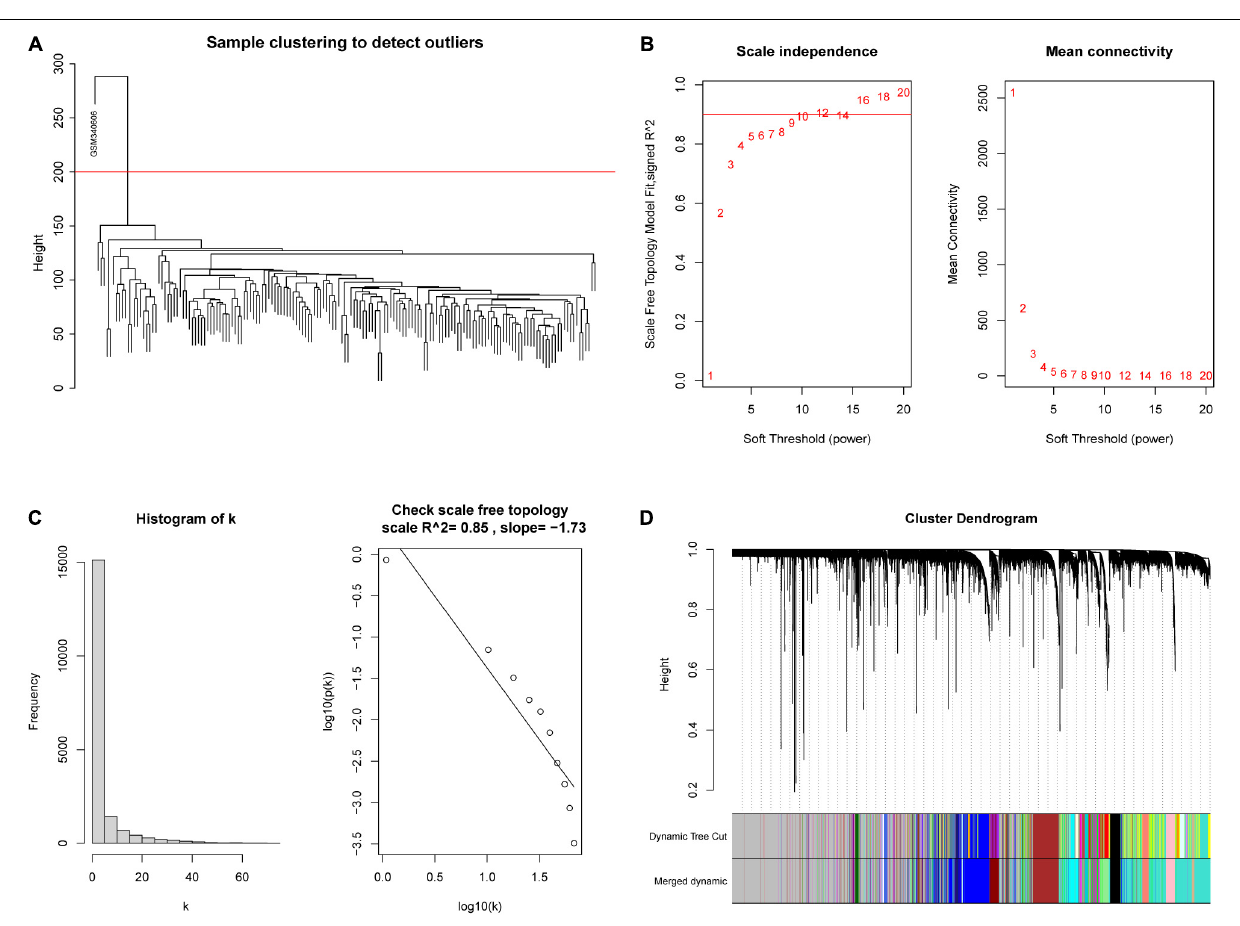
FIGURE 3 | Construction of a weighted co-expression network. (A) An outlier (GSM340606) was detected and eliminated by sample clustering. (B) β = 9 was selected as the soft threshold. (C) Validation of the scale-free topology network. (D) The dynamic tree cutting and merging method resulted in the identification of 24